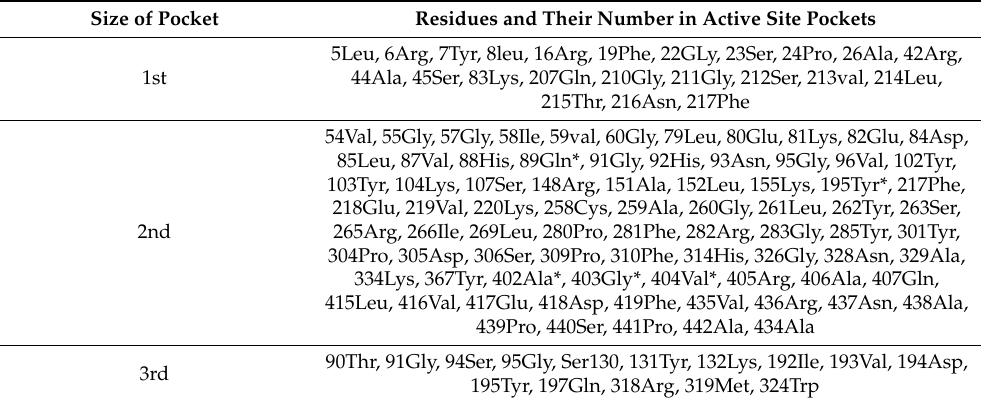
Figure 1. ( a ) L2HGDH gene and the positions of the mutations of respective exon and L2HGDH protein structures. ( b ) A 3D model of wild-type L2HGDH protein and its active site pockets. ( c ) The 3D structure of normal L2GHDH protein and the sites of all reported mutations in black. ( d ) L2HGDH substrate of L2HG. Table 2. CASTp results showing active site pockets in L2HGDH protein. Size of